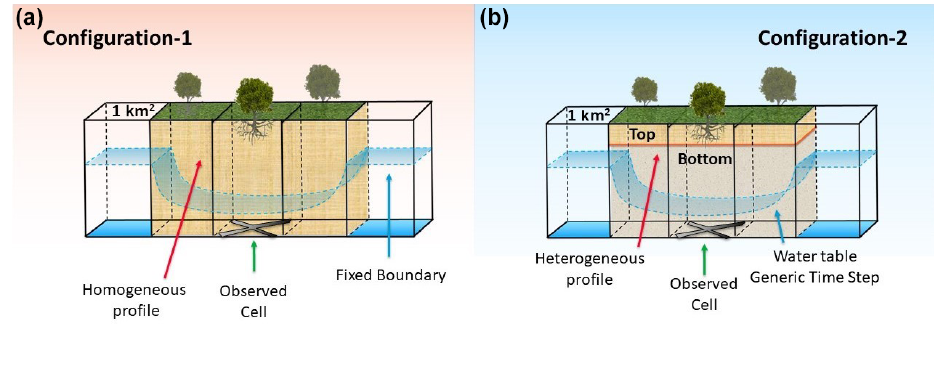
Figure 3. Schematic of the model domain. (a) Configuration-1 models the unsaturated zone as a homogeneous profile with UnSAT. (b) Configuration-2 models the soil heterogeneity by accounting for the change in soil properties with SWAP. The representation of WT levels refers to the generic simulation time and is conceptually showing the depression caused by the root water